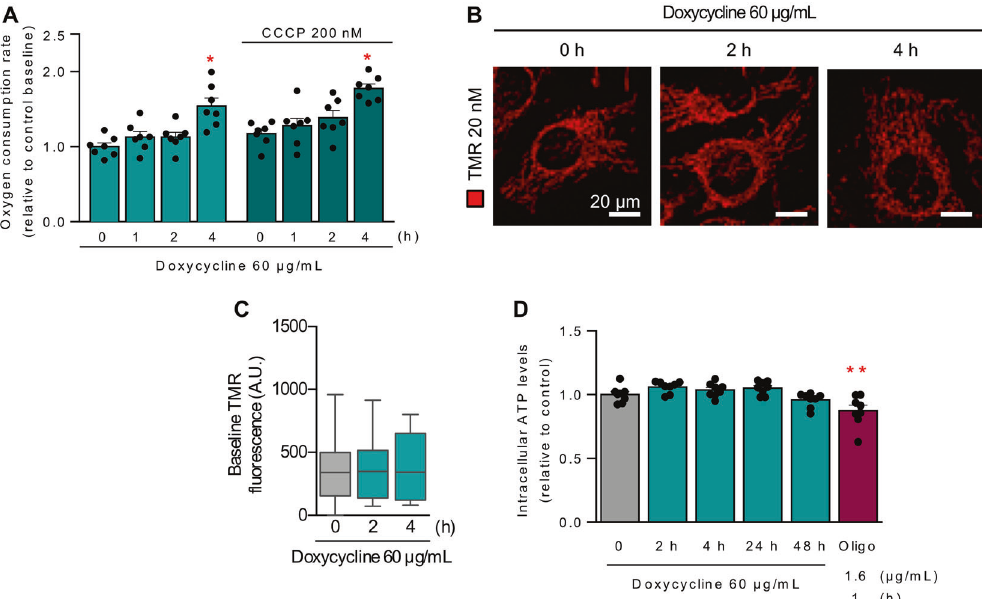
Fig. 4 Doxycycline increases early respiration. A HeLa cells were treated with 60 µg/mL doxycycline for the indicated times, and then mitochondrial respiration rates were measured using a Clark electrode. CCCP 200 nM was used to analyze maximum respiration ( n = 7). B HeLa cells were treated with 60 µg/mL doxycycline for the indicated times, then incubated with TMRM 20 nM for 30 min and analyzed by confocal microscopy. C Quanti fi cation of basal fl uorescence of images obtained in panel ( B ) ( n = 5). D HeLa cells were treated with 60 µg/mL doxycycline for the indicated times, and the relative levels of intracellular ATP were measured by a luminescence-based kit. Oligomycin 2 µM for 1 h was used as a technique control ( n = 8). Results are shown as mean ± s.e.m. Boxplots are presented in Tukey ’ s format. * P < 0.05 and ** P < 0.01 and versus control